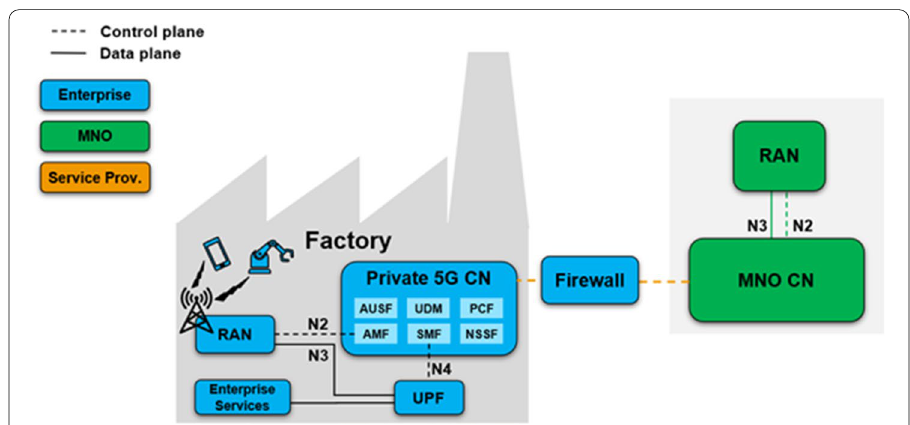
Fig. 8 Fully private model. The private CN may optionally connect to a public MNO’s CN, as the NPN operator can conclude roaming agreements with one or more public network